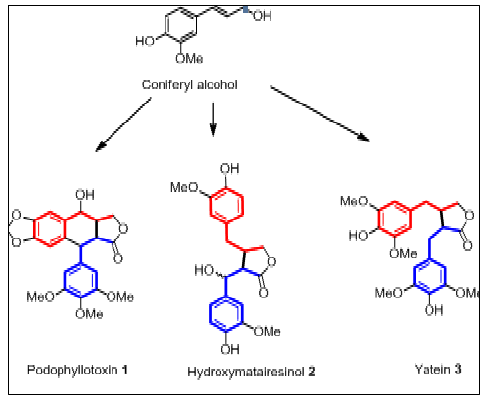
Figure(1):Biosynthesis and example of lignans HMR had stronger lipid peroxidation inhibition capacity than any other lignan or flavonoid tested (8) .HMR was compared to the well-known antioxidants TROLOX (a water- soluble vitamin E derivative), butylated hydroxyanisole, and butylated hydroxytoluene in terms of their ability to inhibit lipid peroxidation, inhibit LDL oxidation, and scavenge superoxide and peroxyl radicals. HMR was found to be